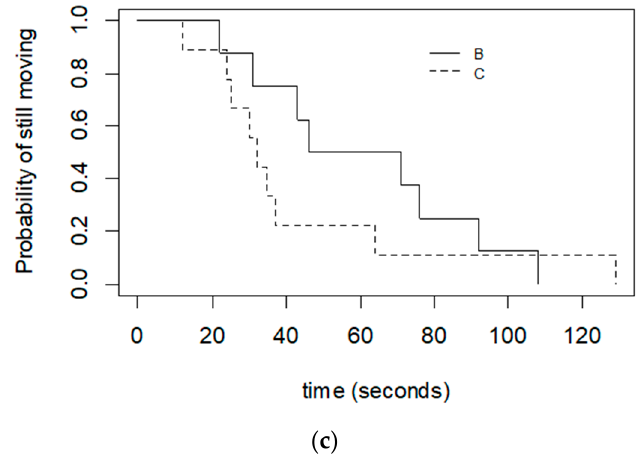
Figure 3. Kaplan–Meier graphs of ( a ) Latency to lose posture, ( b ) Latency to close eyes, ( c ) Latency to cease moving in 17 piglets that were successfully induced into a less-responsive state with either the cuff or the rope, and that did not have the squeeze discontinued for health reasons. Category C piglets ( n = 9) maintained a less-responsive state for the full 10 min squeeze period, whereas the squeeze was discontinued in Category B piglets ( n = 7).